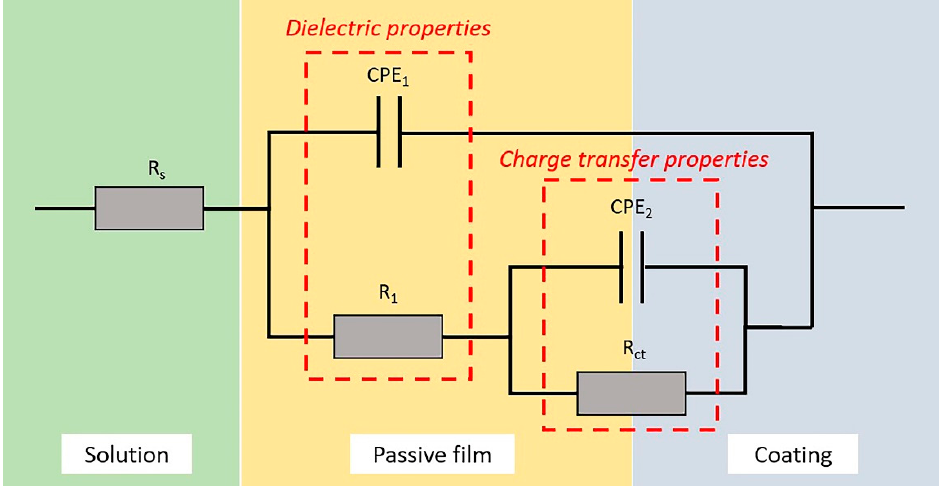
Figure 14. Equivalent electric circuit of the coatings. Table 6. Equivalent circuit parameters of the coatings.